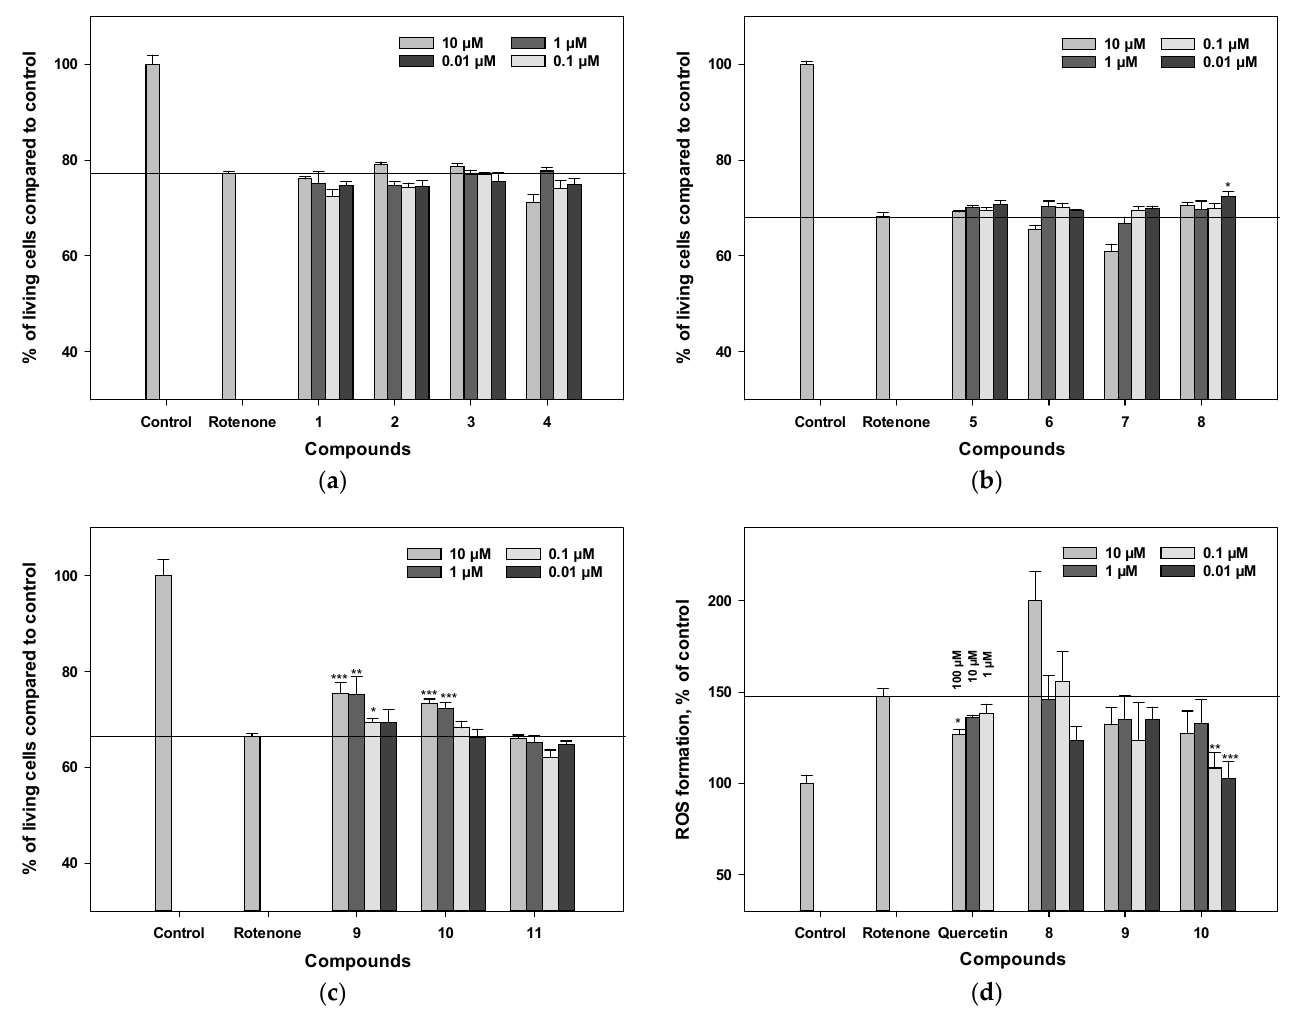
Figure 5. The influence of polyphenolic compounds from L. bicolor on cell viability ( a – c ) and ROS levels ( d ) in Neuro-2a cells treated with rotenone (10 µM). The percentage of living cells treated with compounds and rotenone was measured by the MTT assay. Each bar represents the mean ± SEM of three independent replicates. (*), (**), and (***) indicate, respectively, p < 0.05, p < 0.005, and p < 0.001 versus rotenone-treated cells. The difference between control and rotenone-treated cells was con- sidered significant.